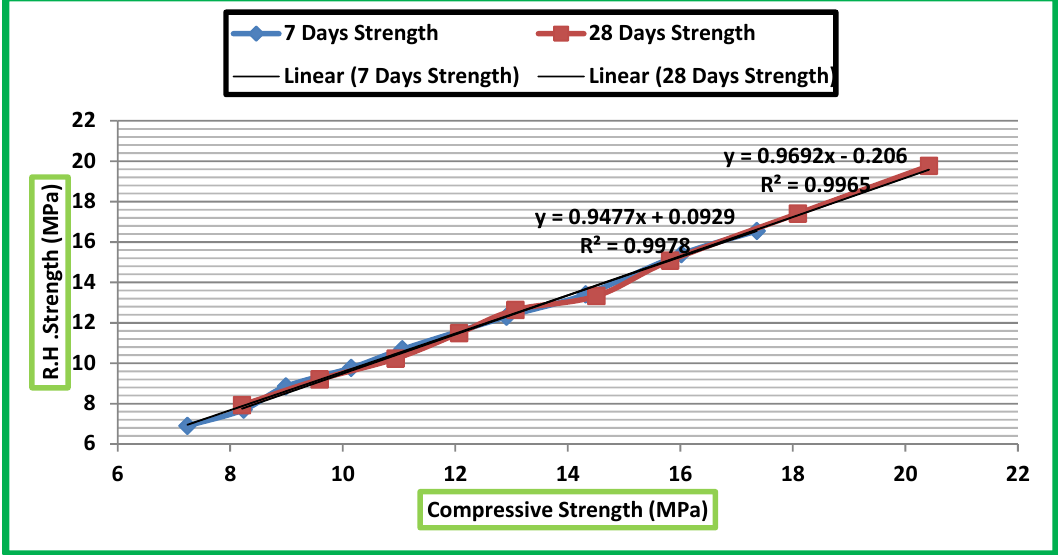
Figure 19. Regression analysis for rebound hammer-based compressive strength (MPa).